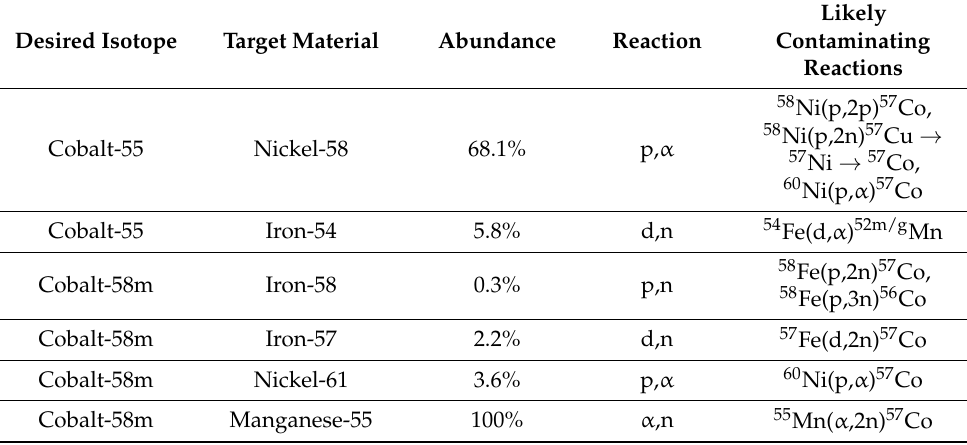
Table 2. Summary of alternative reactions which reduce the radionuclidic purity of 55 Co and 58m Co.